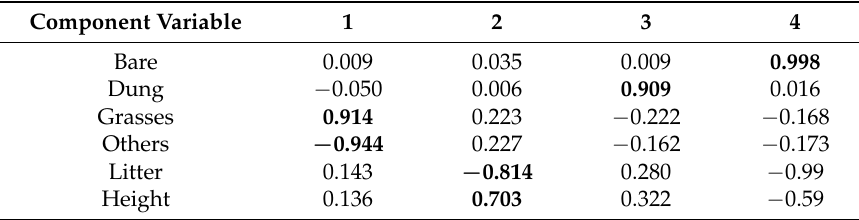
Table 5. Principal component analysis components (1–4) based on the structural pasture characteristics for the three study areas (major loadings are highlighted in bold). Variable names refer to the relative covers of the parameters measured from the digital photographs as well as vegetation height, n =